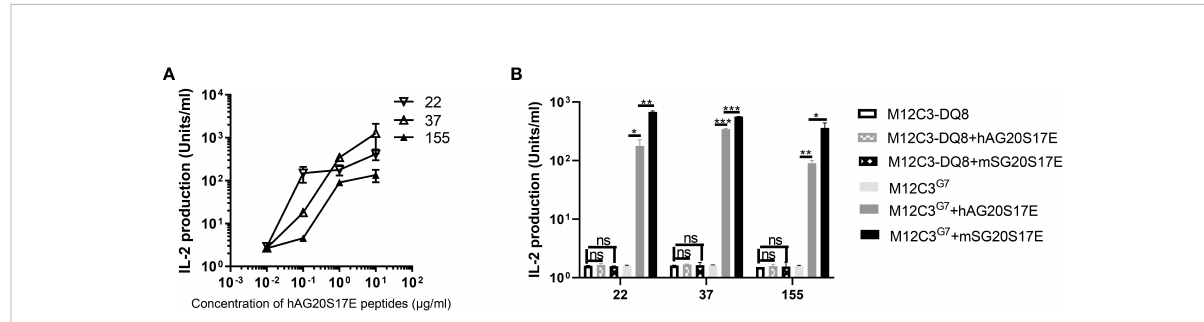
FIGURE 7 Human AG20 peptide cross-reacted with CGRP reactive T cell hybridomas. (A) M12C3 g7 cells incubated with different concentrations of human AG20S17E peptide stimulated mouse CGRP reactive T cell hybridomas 22, 37, and 155. (B) The three representative CGRP reactive T cell hybridomas were stimulated with M12C3-DQ8 incubated with 1 m g/mL hAG20P17E or mSG20P17E and M12C3 cells were used as the negative control. Results are the means ± SEM of triplicate wells. *P P < 0.05, ** P < 0.01, *** P <